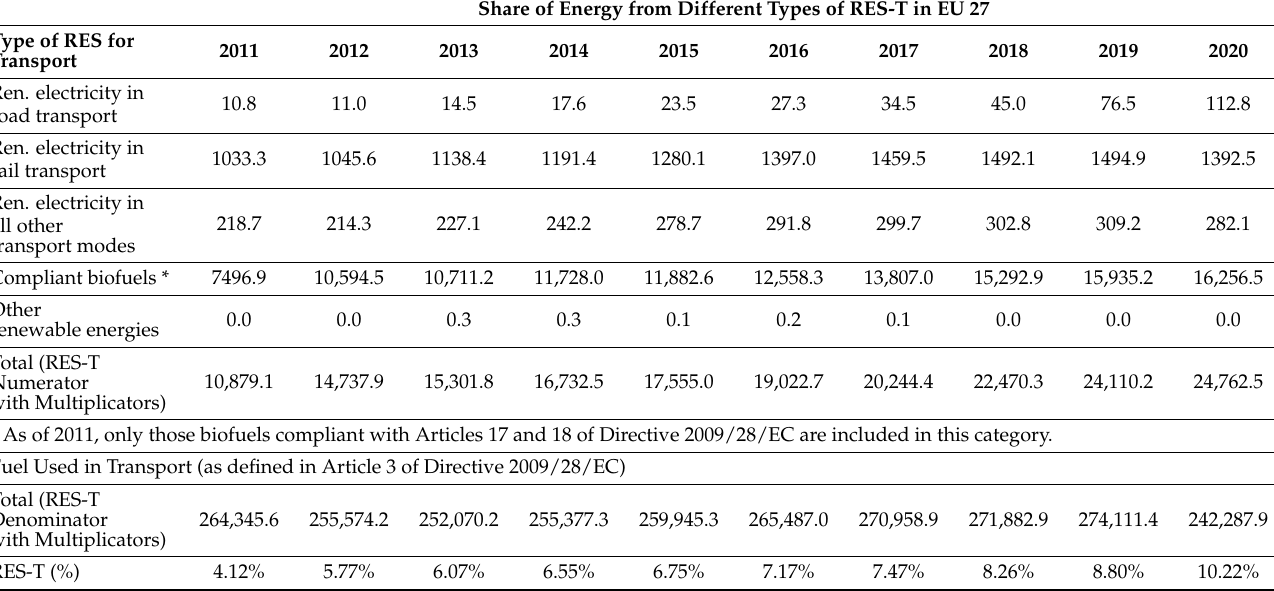
Table 4. Share of energy from different types of renewable sources for transport in EU 27 in the last 10